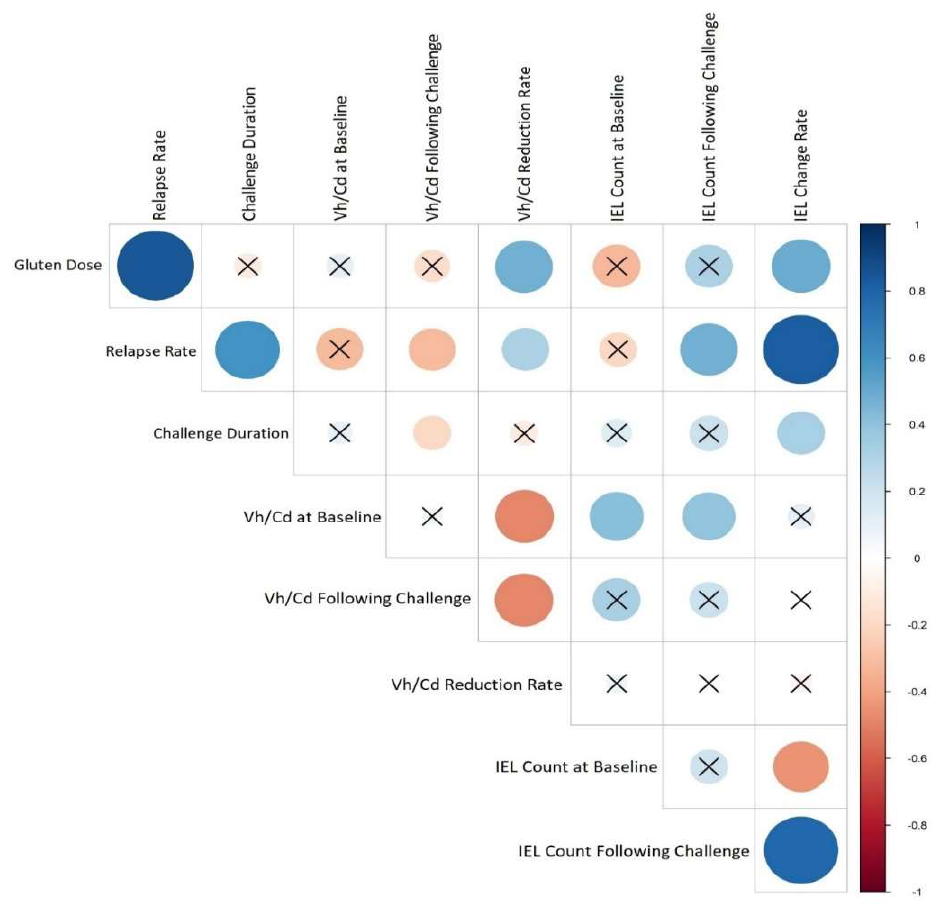
Figure 5. Heat map corresponding to the correlation between CD relapse and studies’ features. Each lattice color represents the intensity of the correlation, with blue representing a positive correlation coefficient and red representing a negative one. Crossed circles represent a non-significant correlation. Large circles indicate a stronger correlation between the row and the column variables.